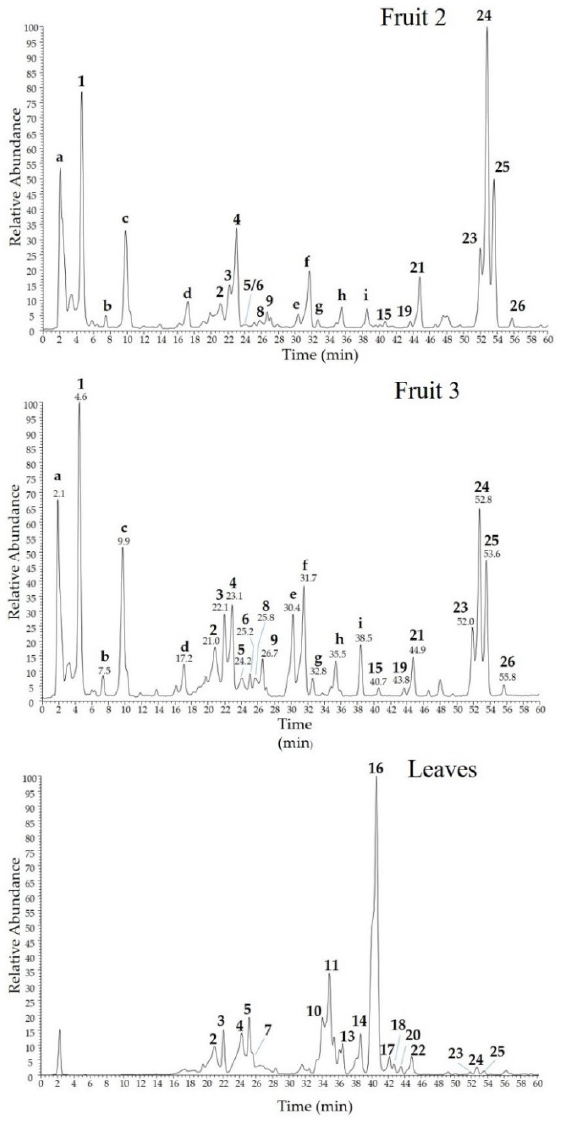
Figure 4. HPLC-ESI-MS/MS profiles of three Malian commercial samples of baobab pulp fruit (Fruits 1, 2, and 3) and leaves. Peak characteristics are showed in Table 2.